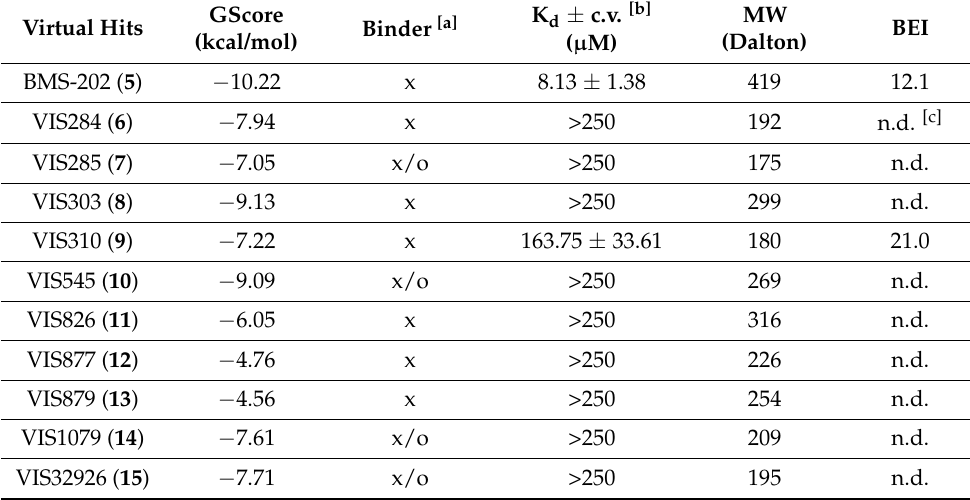
Table 1. Binding energy score (GScore), single-point binder flag, dissociation constants (K d ), molecu- lar weight (MW), and binding efficiency index (BEI) of BMS-202 ( 5 ) and putative hit compounds 6 – 15 against PD-L1.